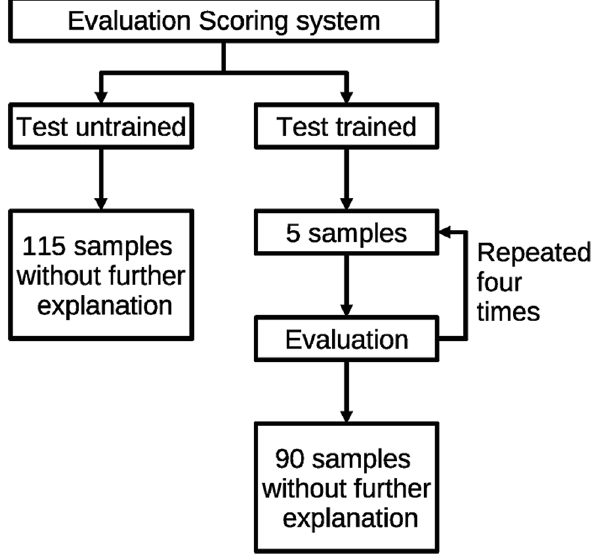
Figure 3. Evaluation of the scoring system. In the first setting, the scoring is done for untrained raters (left) and in the second setting for trained raters